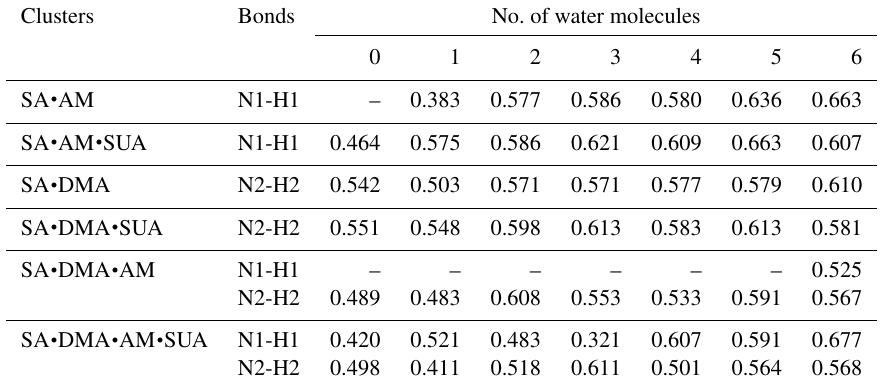
Table 5. Laplacian bond order (LBO) of the newly formed covalent bond (nitrogen–hydrogen bond) between in the clusters (a.u.).